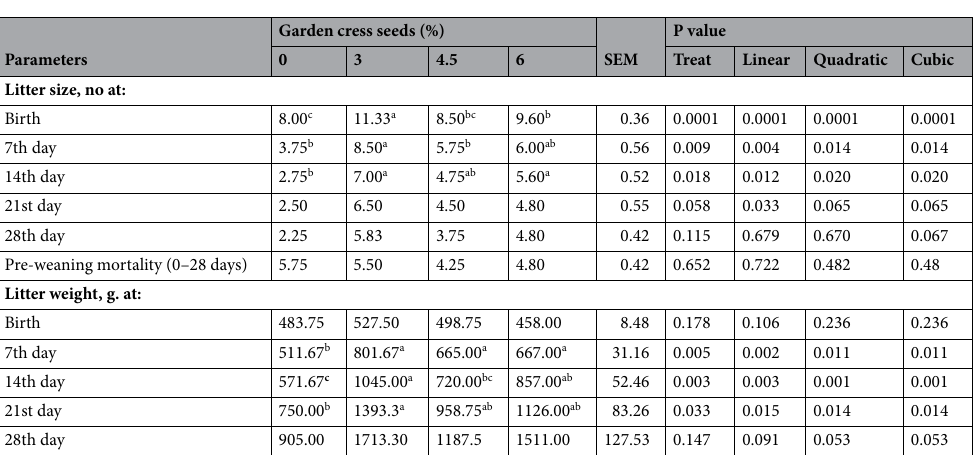
Table 3. Effect of dietary levels of garden cress seeds on some reproductive parameters of doe rabbits. SEM stander error means. Means with different superscripts in the same row are significantly different (p <